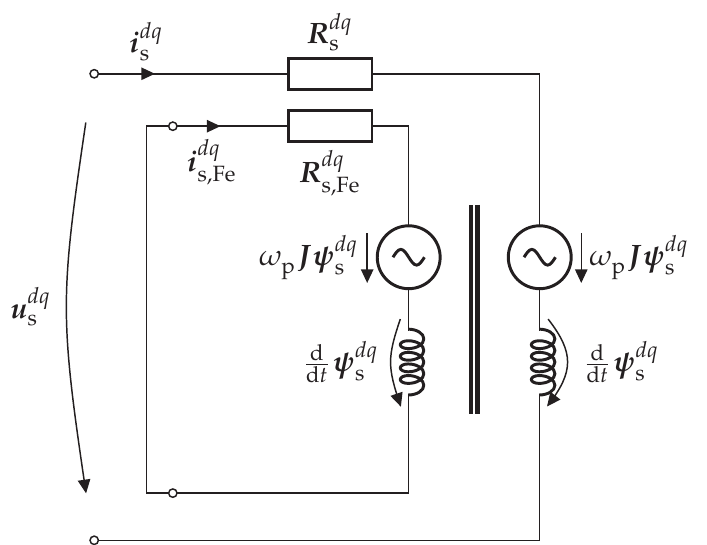
Figure 3. Electrical equivalent circuit of the stator windings and the magnetically coupled iron core in the ( d , q ) -reference